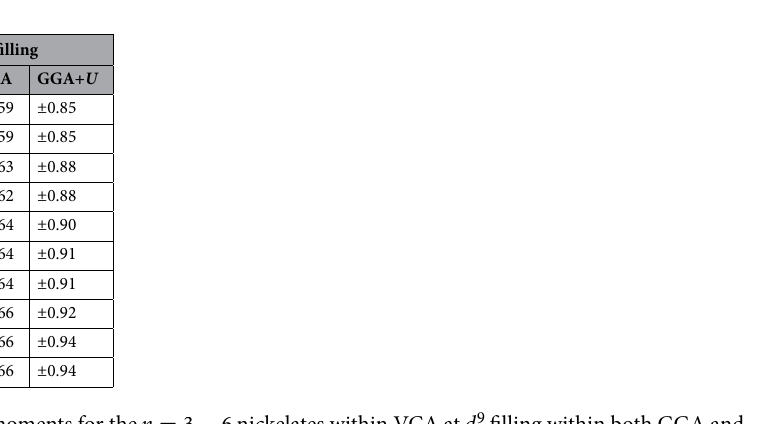
3 6 nickelates within VCA at d 9 filling within both GGA and = −